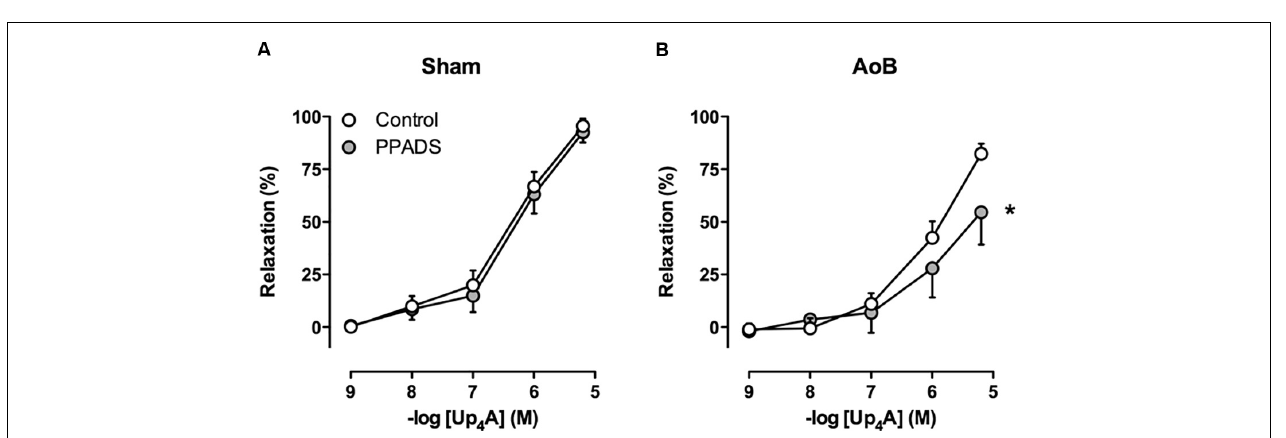
FIGURE 5 | P2 receptor blockade with PPADS had no effect on relaxation to Up 4 A in coronary small arteries from Sham-operated swine ( A , n = 8) but attenuated relaxation in coronary small arteries from swine with AoB ( B , n = 7). Control data are the same as in Figure 2 (‘Sham’ and ‘AoB’). ∗ P < 0.05 effect of PPADS vs. corresponding